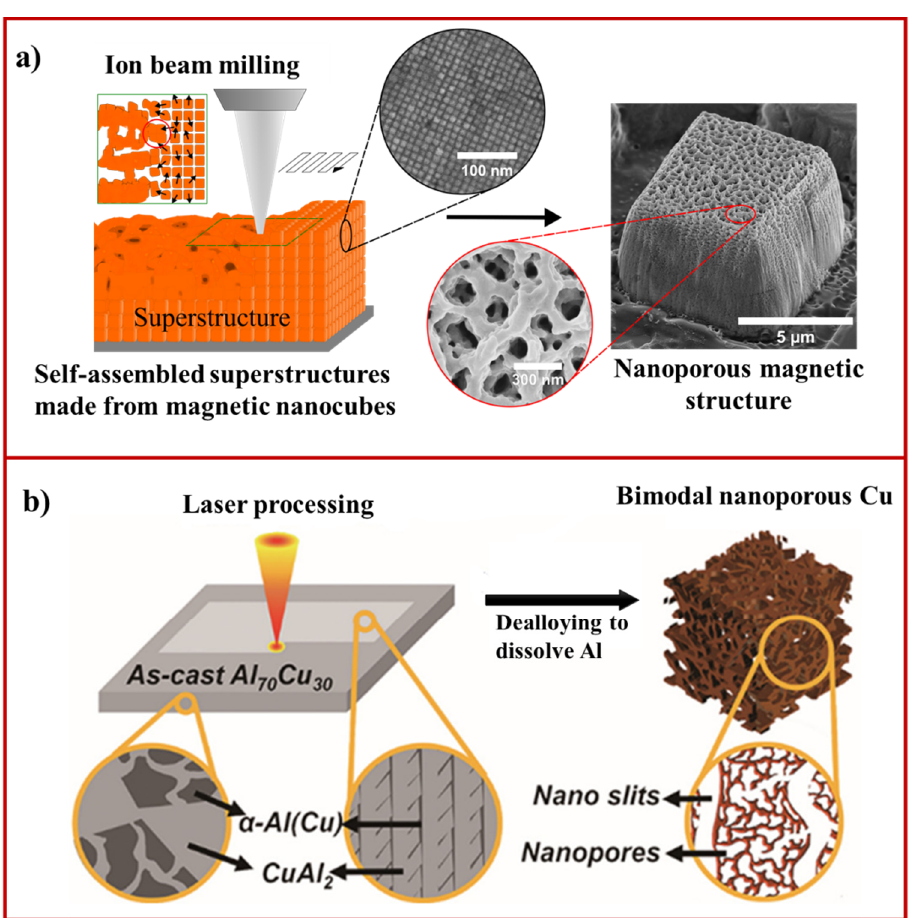
Figure 5. ( a ) The working principle of nanoporous fabrication using focused ion beam milling and melting process (adapted from [127], Copyright 2018 Royal Society of Chemistry); ( b ) schematic illustration displaying the fabrication of bimodal nanoporous Cu by a combined strategy involving laser processing and chemical dealloying (adapted from [129], Copyright 2022,